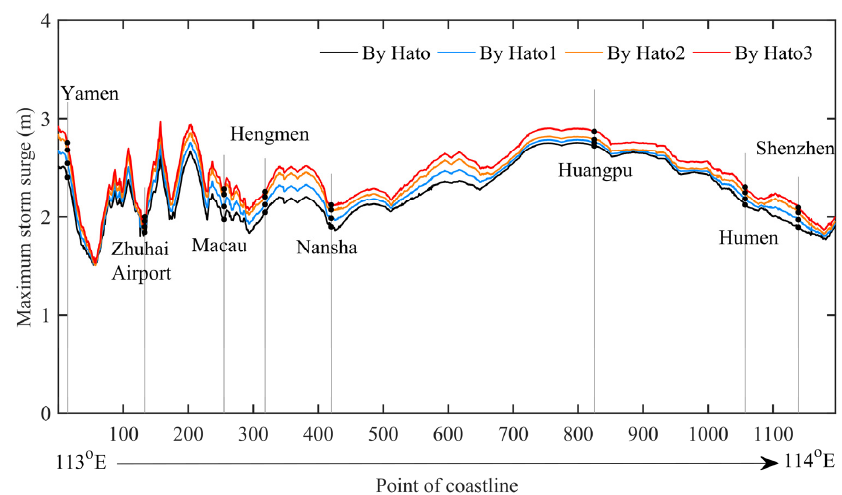
Figure 9 shows the model results for the maximum storm surge generated by the newly 372 constructed typhoons. The maximum storm surge along the PRE increases with decreasing central 373 Figure 9. The curves of simulated maximum storm surge (units: m) generated by di ff erent center Figure 9. The curves of simulated maximum storm surge (units: m) generated by different center 367 moving speed (Figure 9). When the moving speed of the typhoon center decreases by 5 km/h, the 374 moving speeds along the PRE coast. The range of points corresponds to the coastline from 113 ◦ E moving speeds along the PRE coast. The range of points corresponds to the coastline from 113°E to 368 maximum storm surge increases averagely by 0.06 m (2.79%) or the maximum increases by 0.16 m 375 to 114 ◦ E in the Figure 3b. The maximum storm surge induced by Typhoon Hato (2017), Hato1, 114°E in the Figure 3b. The maximum storm surge induced by Typhoon Hato (2017), Hato1, Hato2, 369 (6.75%). That is to say, the average and maximum increases in the maximum storm surge are less 376 and Hato3 are marked with black curve, blue curve, orange curve, and red curve, respectively. Some 370 Hato2, and Hato3 are marked with black curve, blue curve, orange curve, and red curve, respectively. than 0.5 m when the central moving speed of the typhoon decreases from 30 km/h (Hato) to 15 km/h 377 famous stations of the coastal area are marked in sub figures to show their storm surges. 371 Some famous stations of the coastal area are marked in sub figures to show their storm surges. (Hato3). This indicates that although the moving speed of the typhoon center does affect the storm 378 surges in the PRE, the effect is not significant. 379